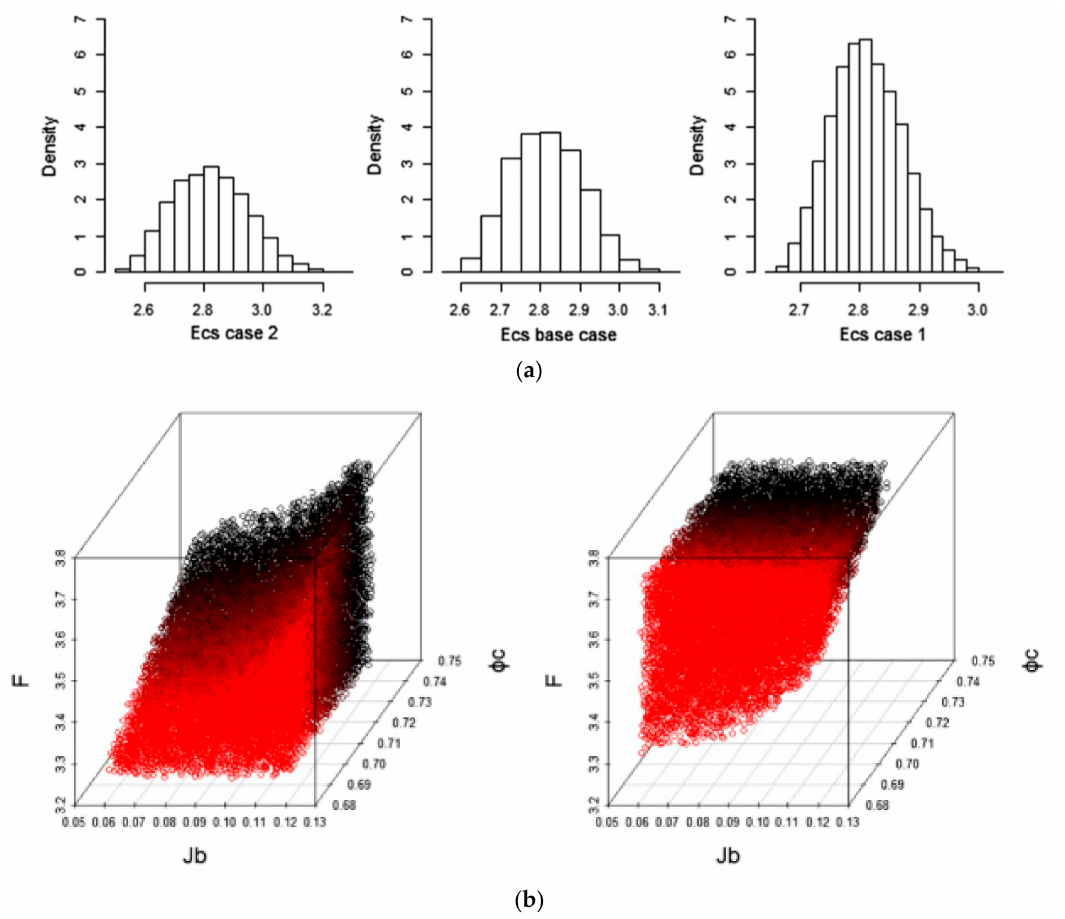
Figure 12. ( a ) The comminution-specific energy histogram of a SAG (semi-autogenous grinding) mill under three uncertainty magnitudes. ( b ) The regionalization of fresh ore flux fed ( F ), percentage of mill volume occupied by steel balls ( J b ), and percentage of critical speed ( φ c ) [162].